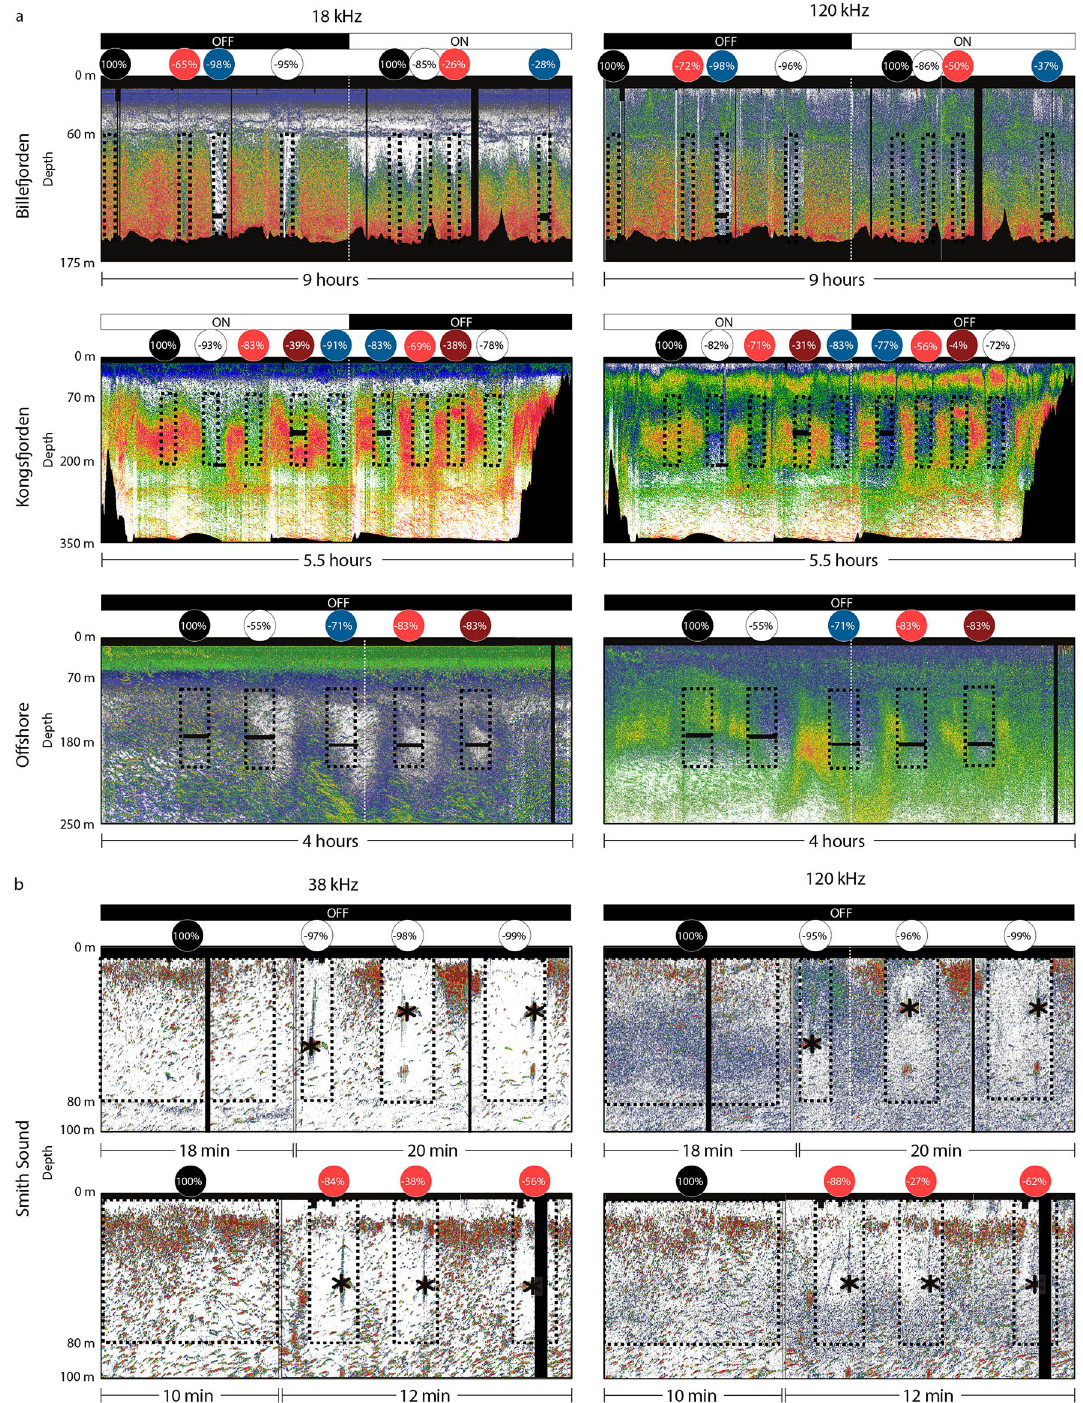
Figure 4. Volume backscattering strength echograms (S v ) from the EK60 echosounder during ( a ) the Svalbard and ( b ) Newfoundland experiments. The dashed rectangles represent each deployment, and the first rectangle of each echogram represents the control deployment. The corresponding circles on top are coloured according to the filter being used and indicate the percentage reduction in area backscattering coefficient (s a ). Black and white bars on top of the echograms indicate when the ship’s lights were on and off. Black areas represent areas removed from the analyses because of noise or depths below the seafloor. The asterisks indicate the location of the baited camera during the Newfoundland experiment. Note that the signal from the camera was removed from the analyses. Higher S v threshold is − 50 dB for all echograms and lower S v threshold is − 90 dB for Billefjorden and Newfoundland, − 95 dB for Kongsfjorden, and − 110 dB for the offshore